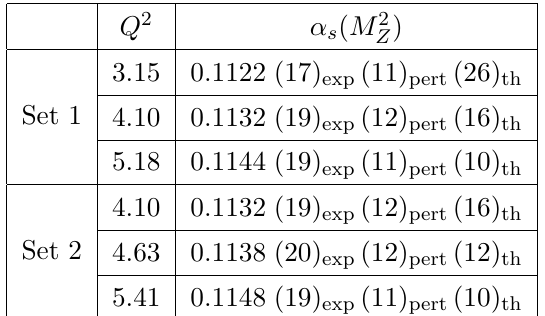
Table 4 . The two sets of three Q 2 points chosen for the averages with their experimental (exp), perturbative (pert) and theoretical (th) symmetrized uncertainties. By perturbative uncertainty we mean the uncertainty coming from the use of perturbation theory in the regions 1 . 8 GeV < √ 3 . 7 GeV and s > 5 GeV for the ratio R ( s )